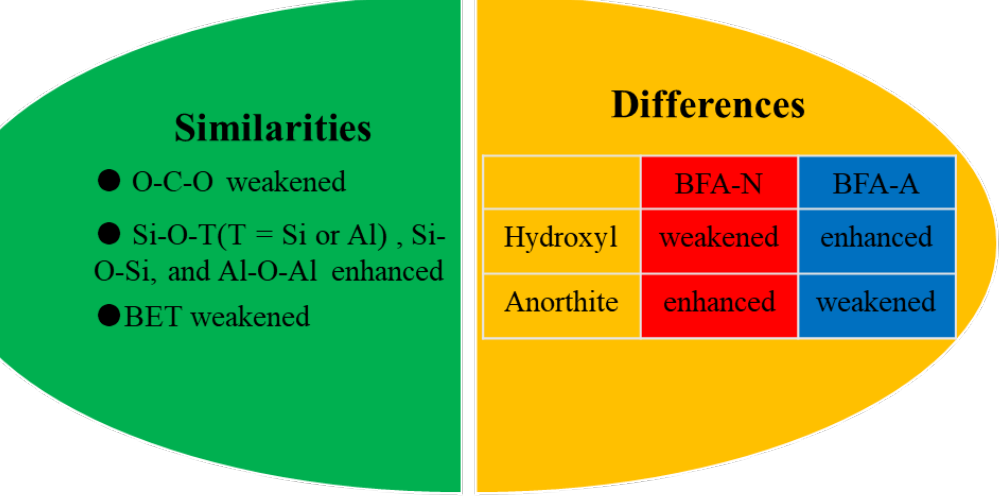
Figure 5. Similarities and differences in physicochemical properties’ change between BFA-N and BFA-A.